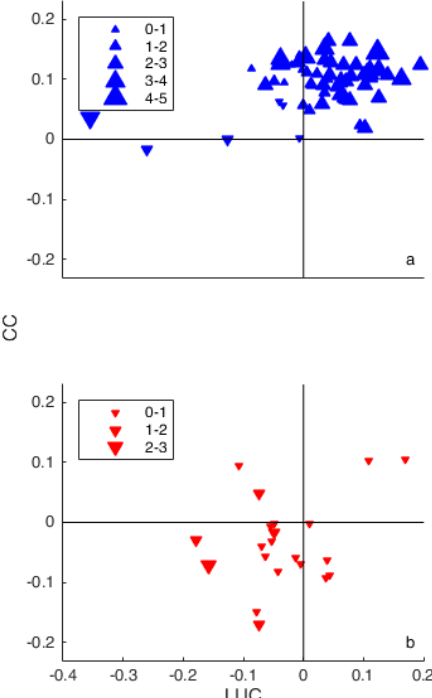
Figure 5. Contribution of land use change ( x -axis) and climate change ( y -axis) for ( a ) the American and ( b ) Australian catchments with a significant trend in discharge and significant LUC and / or CC values. The magnitude of the discharge trend (estimated with Sen’s slope estimator) is shown in mm y − 1 .